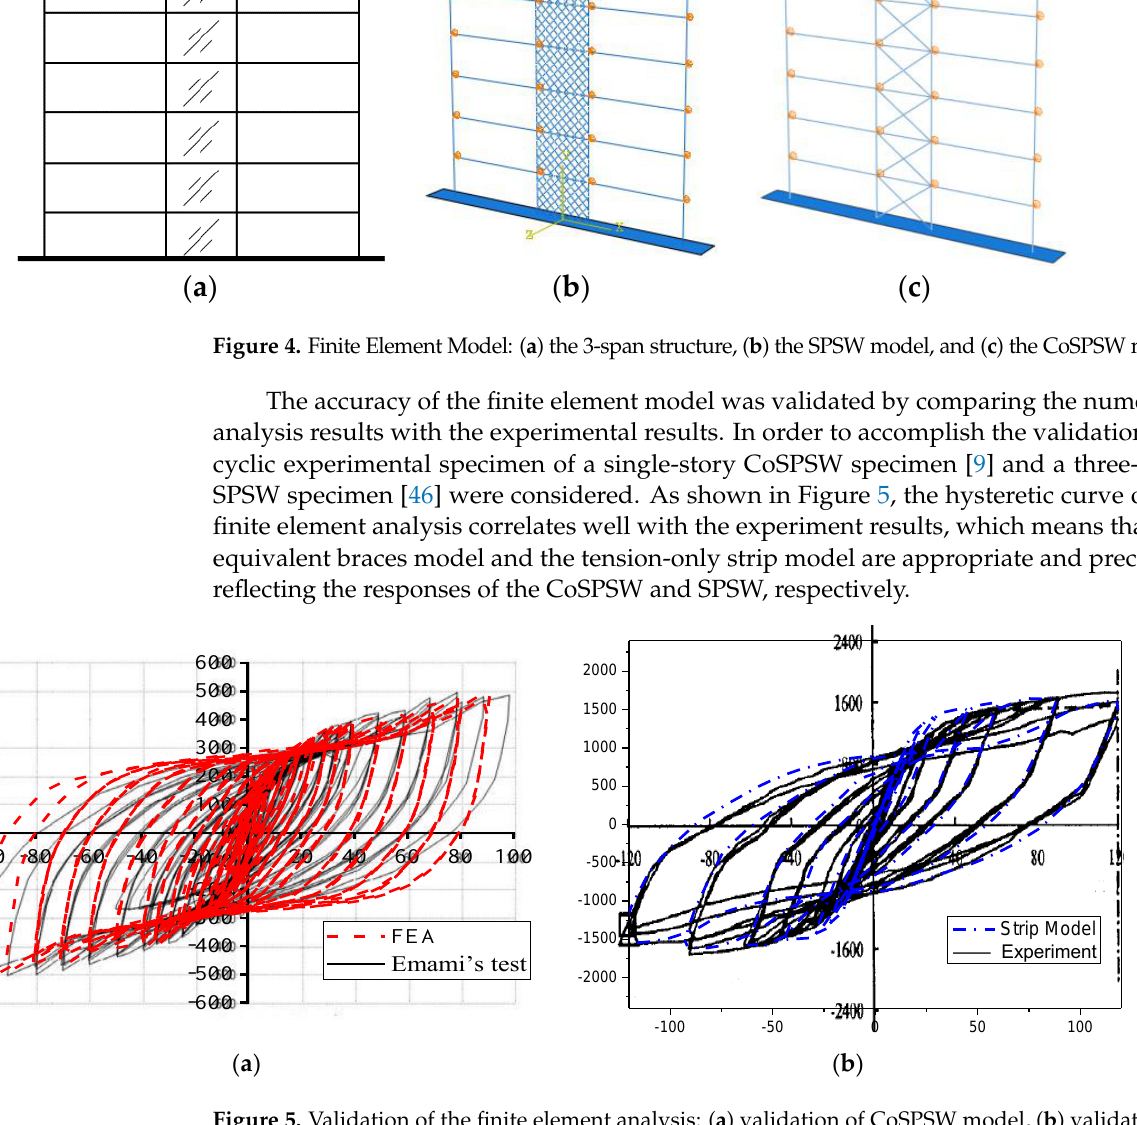
Figure 5. Validation of the finite element analysis: ( a ) validation of CoSPSW model, ( b ) validation of SPSW model.